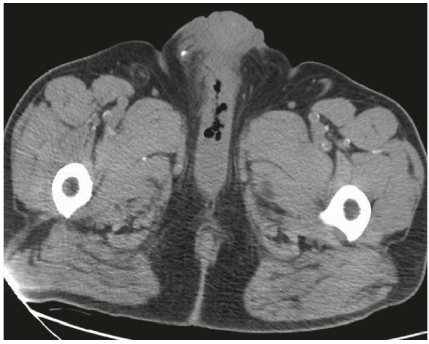
Figure 2: Axial view of pelvic CT image demonstrating emphy- sematous changes in the bulb of the corpus spongiosum.